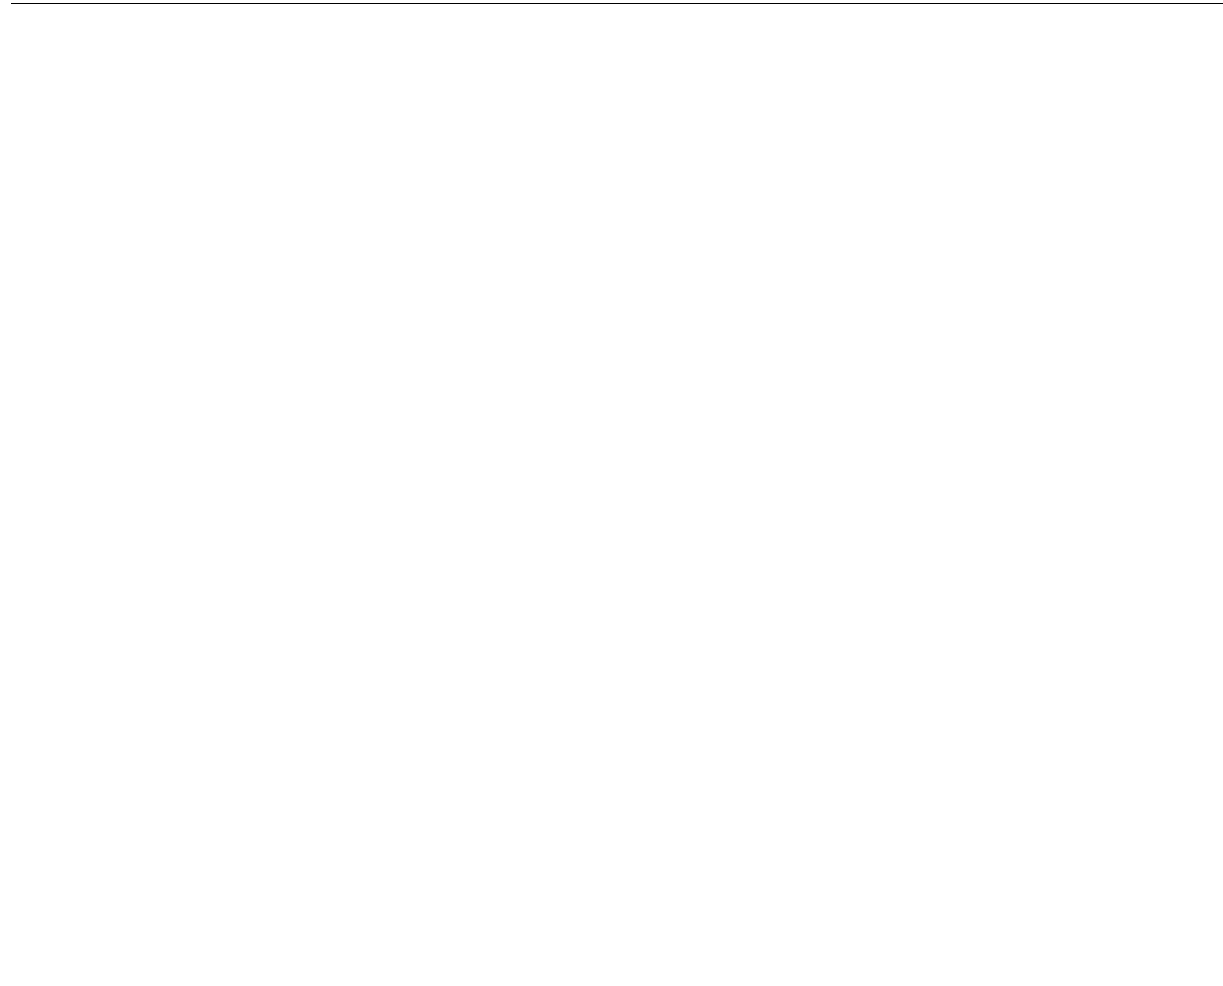
Table 1: Calculating the carbon footprint of a given streaming program Length of the streaming video in hours × GB per hour for a given resolution (Summerson 2018) × gigabytes per hour for a given resolution (Summerson 2018): 480 pixels: ~792 MB/hour 720p: ~1.3 GB/hour 1080p: ~1.9-2.55 GB/hour 1440p: ~2.8 GB/hour 4K: ~3.5-7 GB/hour × energy intensity: 4.91 kWh/GB (see above) × number of unique viewers × 0.707 kgCO 2 e/kWh (Environmental Protection Agency 2020) = carbon footprint in kilograms of CO 2 e (CO 2 and other greenhouse gases). For larger volumes